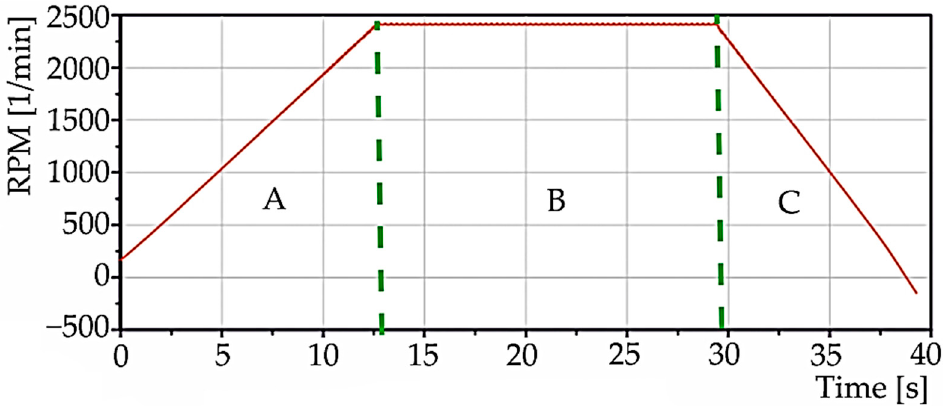
Figure 15. Time waveform of signals during machine spindle start ‐ up for speed (simultaneous data